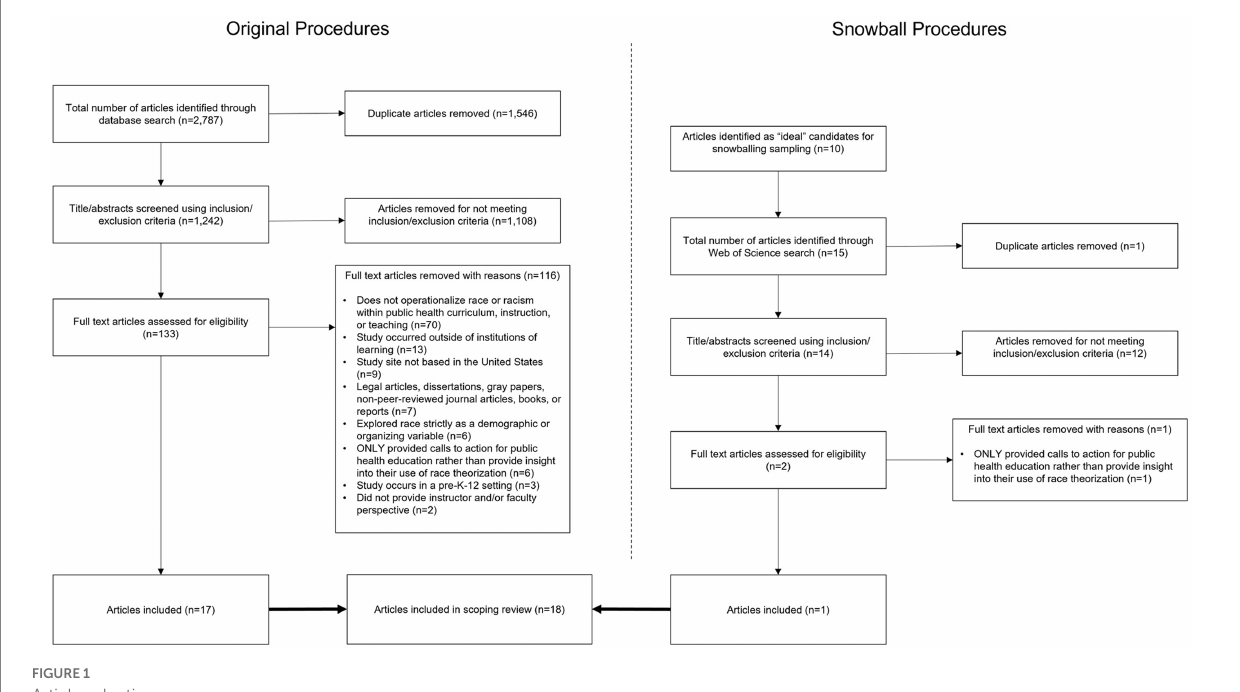
FIGURE 1 Article selection